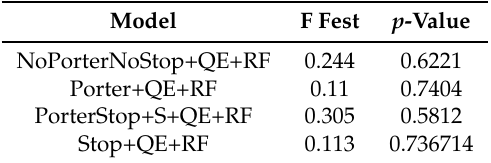
Table 31. T2: ANOVA test results for indexes for